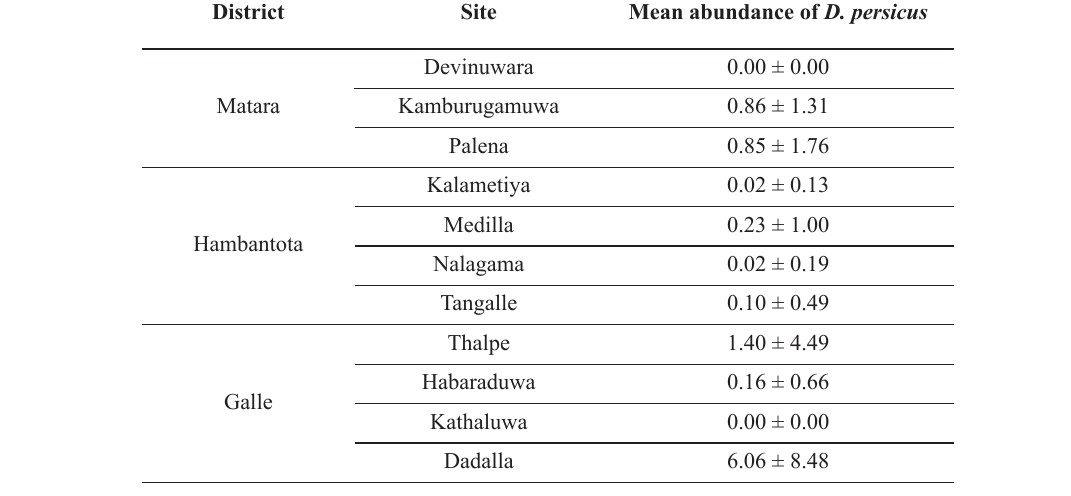
Table 1: Temporal variation of mean abundance (± S.D.) of D. persicus across the sites of Galle, Matara and Hambantota districts. District